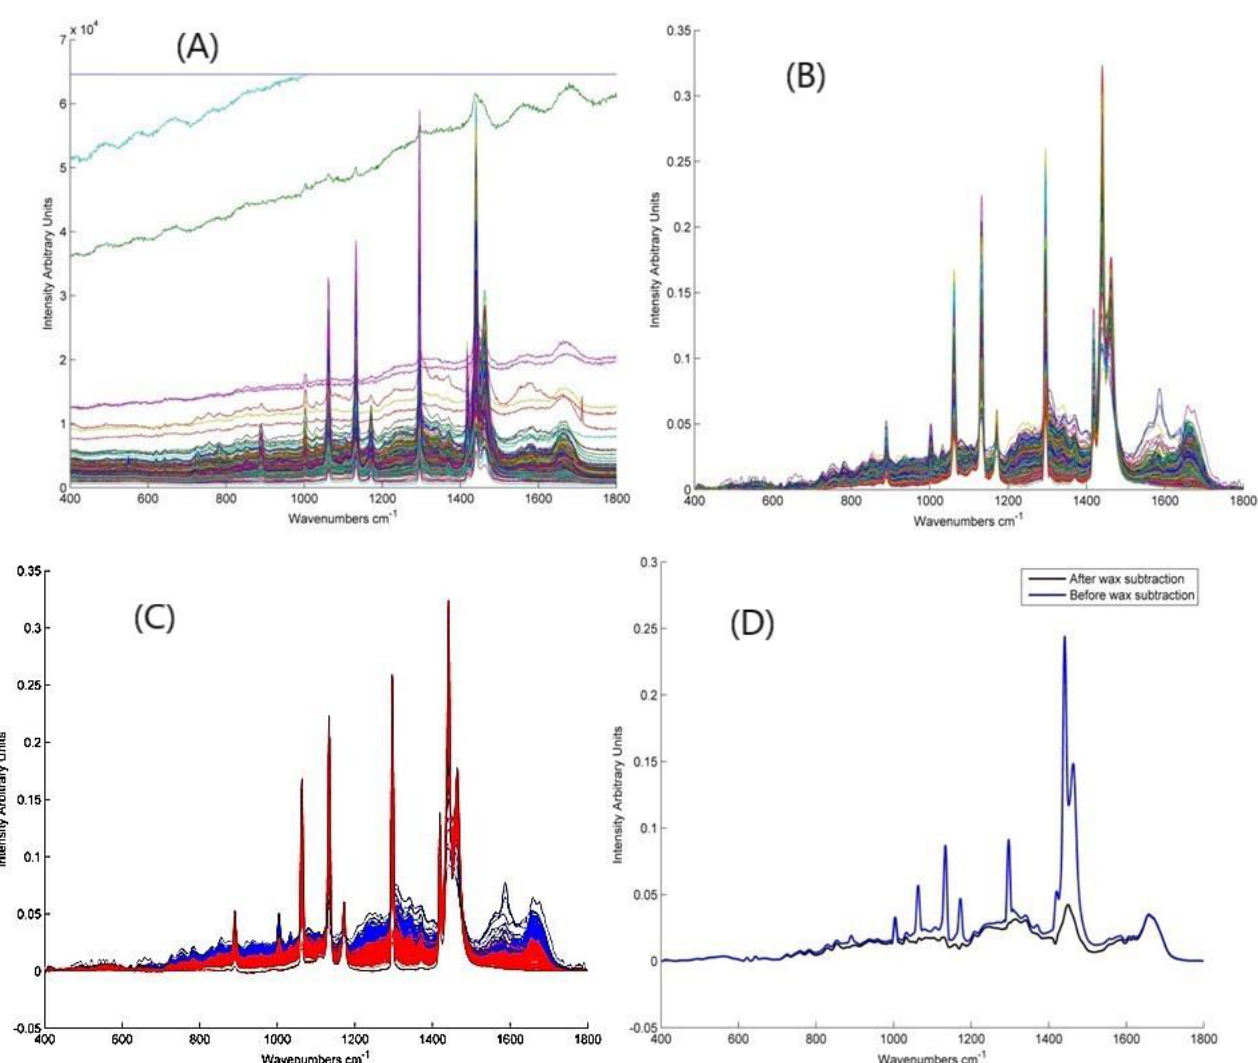
Figure 7. Spectral processing steps ( A ) Raw spectra. ( B ) Spectra after first quality control step, smoothing, baseline correction and normalization. ( C ) Spectra after k-means grouping; the spectra in red have high wax and low biological content while those in blue have higher biological content and less wax. ( D ) Spectra after glass and wax subtraction.